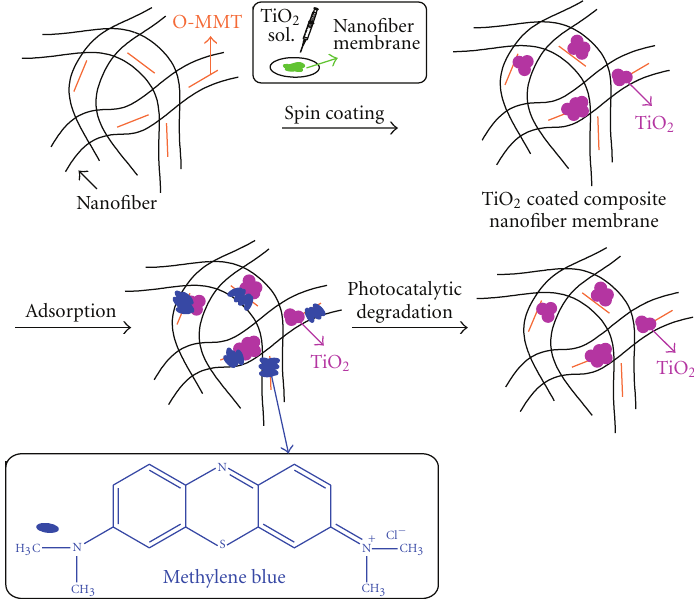
Figure 9: The flow chart of the formation of the composite membranes and the process of adsorption and photocatalytic degradation.